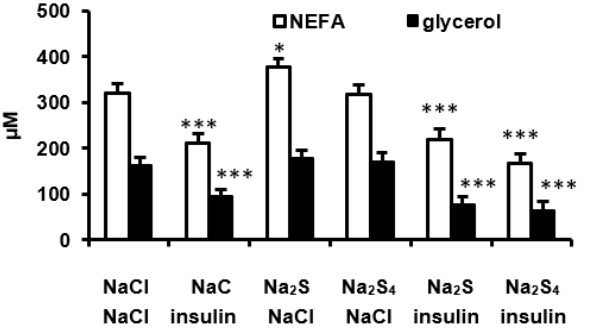
Figure 3. Effect of Na 2 S and Na 2 S 4 (both at 100 μmol/kg) administered 15 min before insulin (0.5 U/kg) on plasma non-esterified fatty acids and glycerol 45 min after insulin administration. * p < 0.05, *** p < 0.001 vs. control group receiving two NaCl injection.